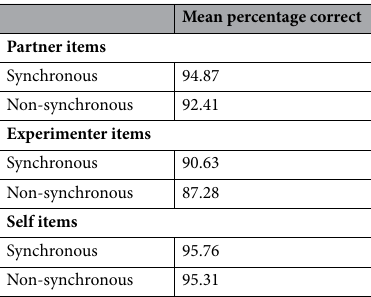
Table 3. Mean percentage correct scores for the preference overlap